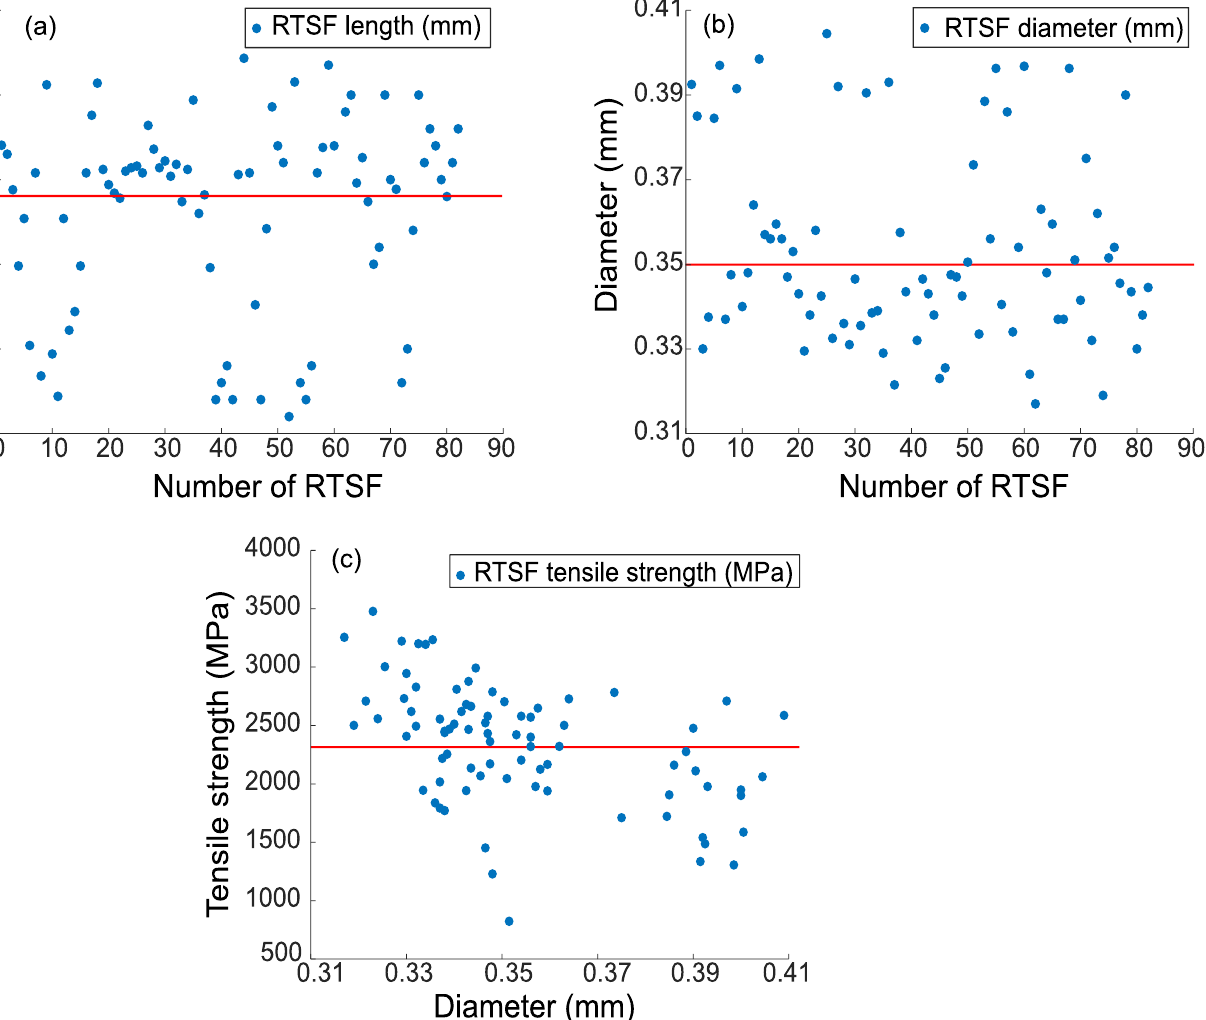
Figure 4. Average ( a ) length, ( b ) diameter, and ( c ) tensile strength of the